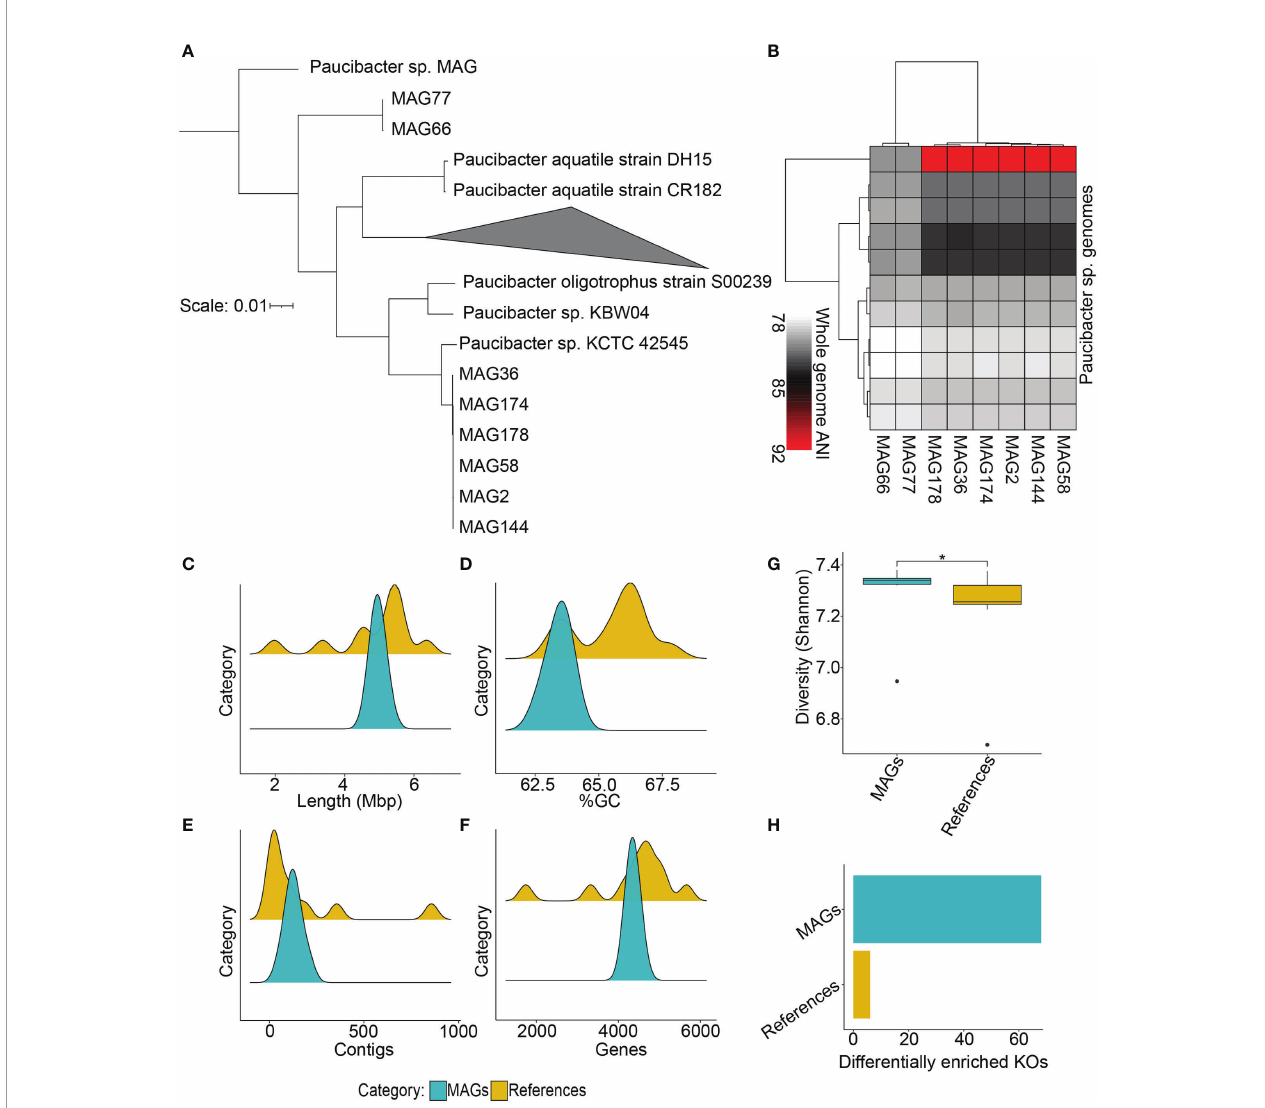
FIGURE 6 | Comparative analysis of Paucibacter MAGs and reference genomes. (A) Phylogenetic analysis between Paucibacter MAGs and reference genomes is shown which indicates that the majority of MAGs were phylogenetically distinct from the reference species, as the MAGs clustered separately from them. (B) Whole- genome-based average nucleotide identity (ANI) analysis indicated that the majority of the Paucibacter MAGs shared at most 92% ANI with the reference genomes, indicating their potential of being novel species of the Paucibacter genus. (C – F) Comparisons of genome lengths, %GC, number of contigs, and number of predicted genes between MAGs and references. (G) Comparison of metabolic diversity (Shannon index) between the two groups indicates that MAGs had signi fi cantly higher diversity than references (Wilcoxon test, P < 0.05). (H) Barplot indicating the number of DE KOs in the two groups. The Paucibacter MAGs had a signi fi cantly higher number of DE KOs in contrast with Paucibacter reference genomes. *P <=